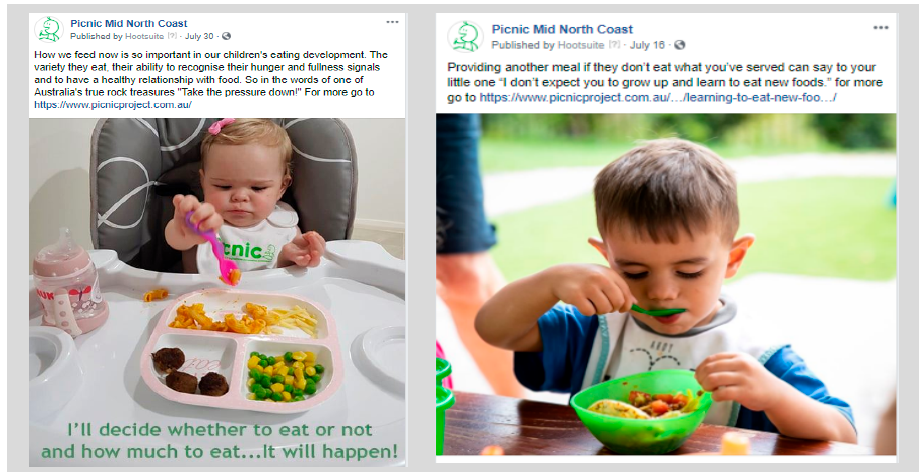
Figure 3. Examples of proposed “meme style” social media messages on PICNIC Mid North Coast.